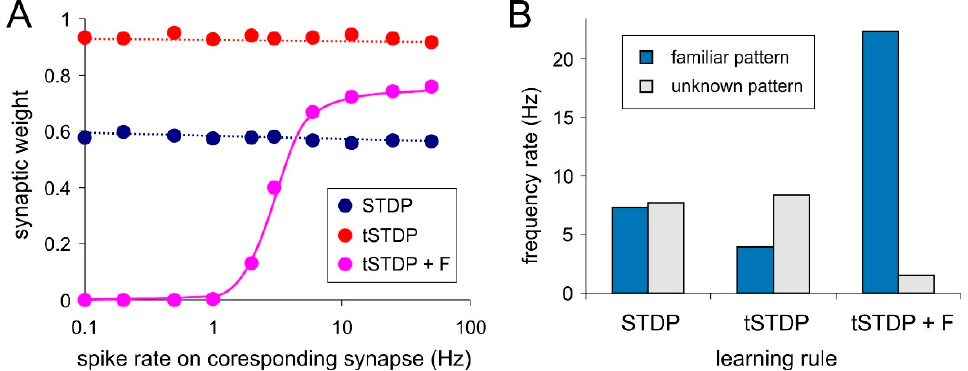
Figure 4. Rate coding results with pair-based rule (STDP) triplet-based rule (tSTDP) and triplet-based rule with forgetting function (tSTDP + F): ( A ) Synaptic weights vs. spike rate on corresponding synapse; ( B ) The response of the postsynaptic neuron to familiar and unknown pattern.